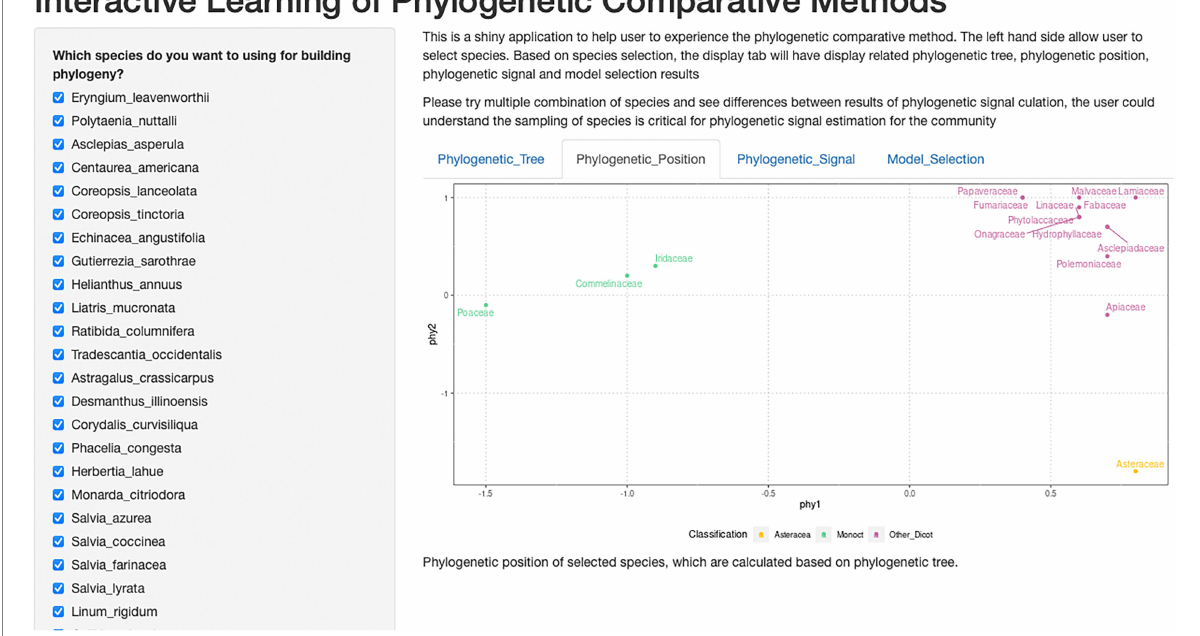
FIGURE 2 Shiny application of interactive learning of phylogenetic comparative methods. This is a screenshot of the shiny application. The checkbox of species could be used to choose different combinations of species and explore its impact on phylogenetic